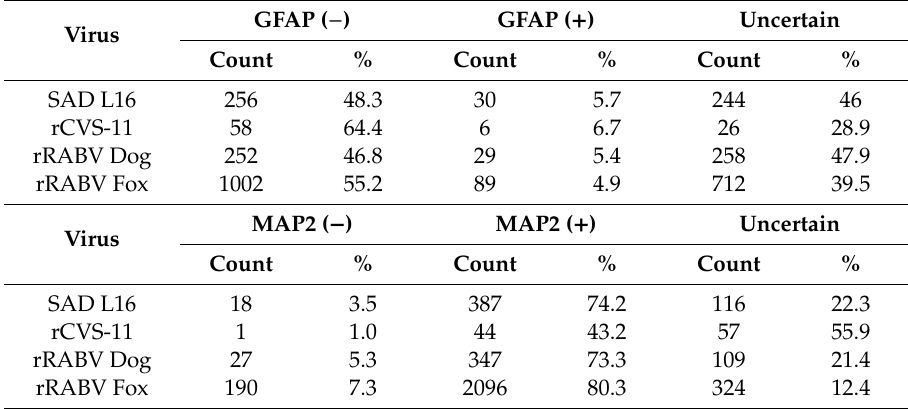
Table 1. Infection of GFAP- and MAP2-expressing cells in hippocampus cell cultures. RABV-infected cells were counted after indirect immunofluorescence detection of RABV N protein and subdivided in cells that were either negative ( − ) or positive ( + ) for GFAP / MAP2. Because of overlaying positive and negative cells in GFAP and MAP2 stainings, a clear assignment was not always possible. Such cells were classified as uncertain. CVS: Challenge Virus